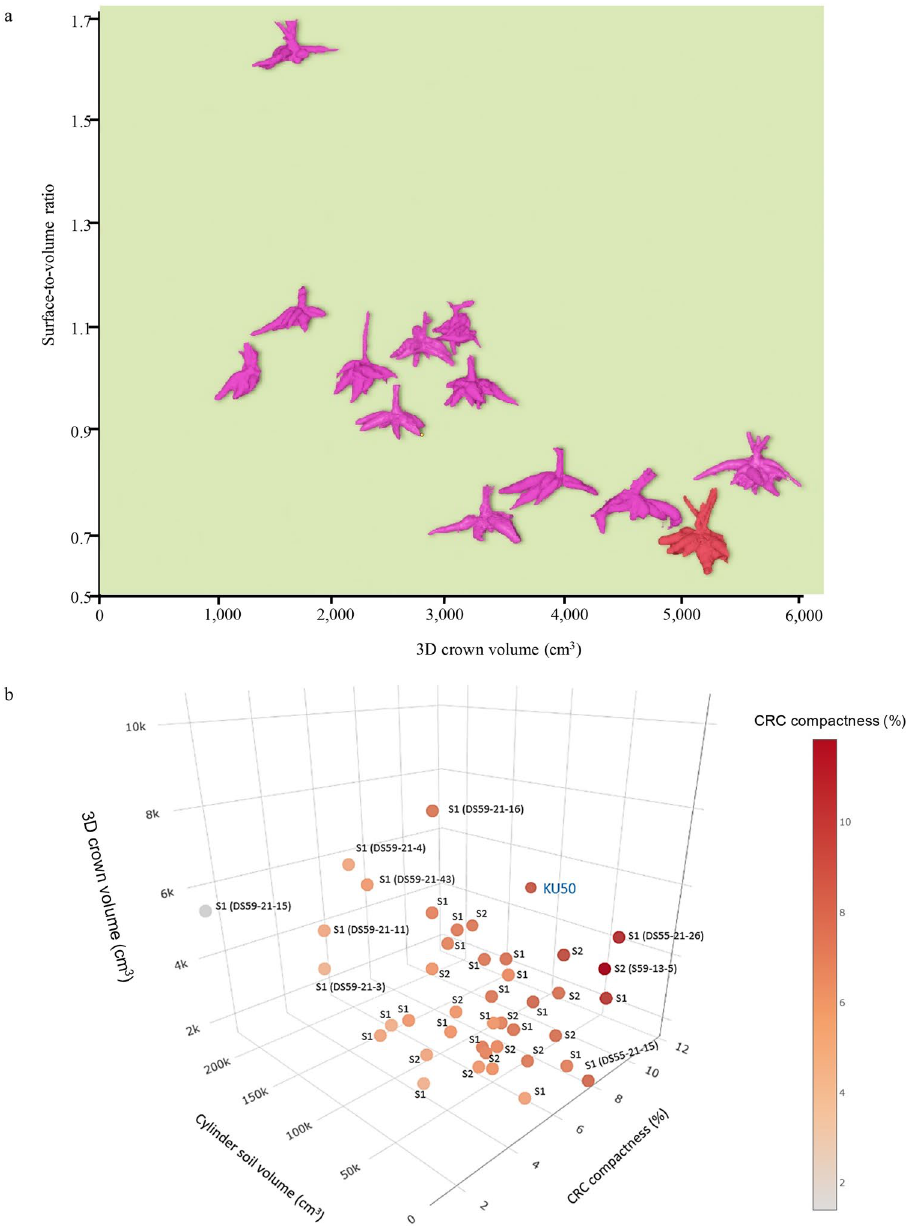
Figure 9. ( a ) Segregations of the 12 S 2 population plotted between for surface-to-volume ratios and 3D crown volumes. Representative 3D CRC models for each S 2 lines were selected from 3D models with median values. KU50 (S 0 ) is presented in red. ( b ) A 3D scatter plot of 3D crown volume, cylinder soil volume and CRC compactness for 29 S 1 , 12 S 2 , and KU50 using adjusted means from augmented RCBD